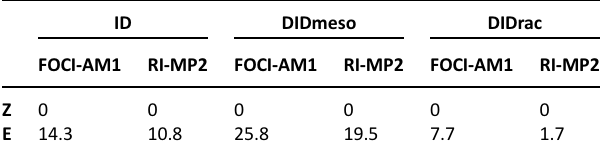
Table 3. Energy differences for the ID , DIDrac , and DIDmeso iso- mers in the ground